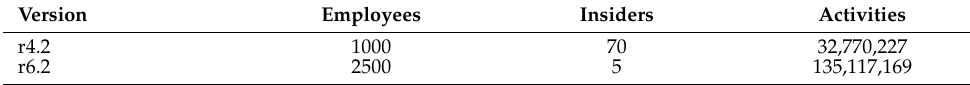
Table 2. CERT datasets r4.2 and r6.2 statistics.